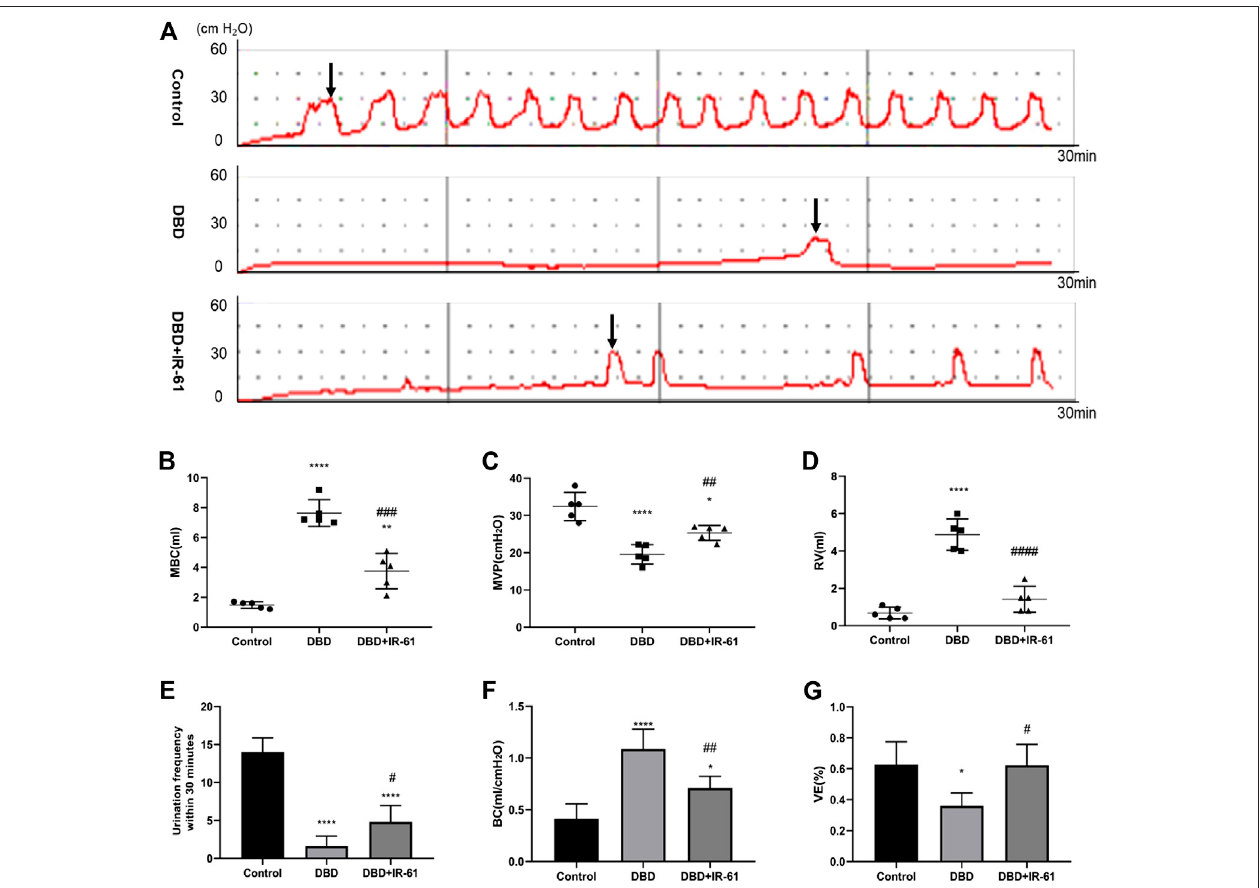
FIGURE 2 | Cystometry results of all groups (n (cid:2) 5). (A) Representative cystometry curves of rats in each group. (B) Maximum bladder capacity (MBC) (C) Maximum voiding pressure (MVP). (D) Residual volume (RV) (E) Frequency of urination in 30 min (UF30 min). (F) Bladder compliance [BC; calculated as MBC/(TP-BP)]. (G) Voiding ef fi ciency {VE, calculated as [(MBC − RV)/MBC] × 100%}. Data indicate the mean ± SD (* p < 0.05, ** p < 0.01, *** p < 0.001, **** p < 0.0001 vs. control group; # p < 0.05, ## p < 0.01, ### p < 0.001 vs. DBD group). Black arrows indicate the micturition peaks.